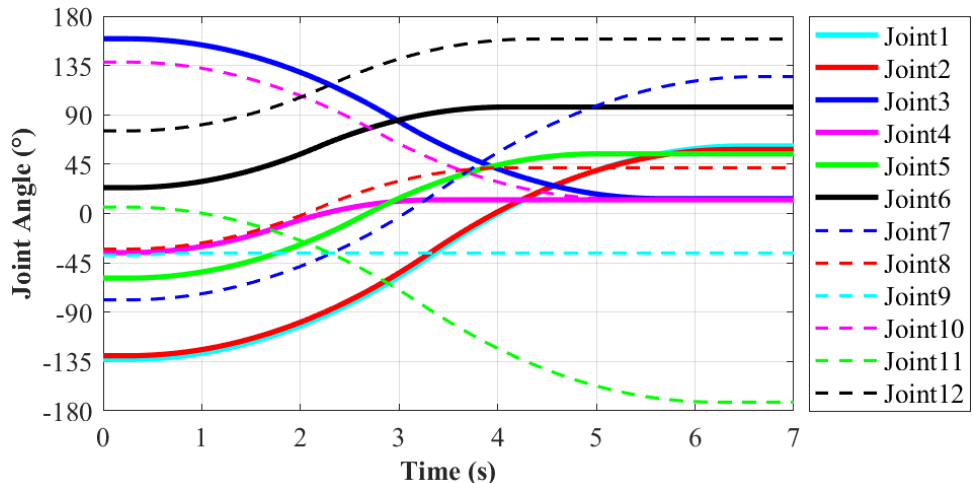
Figure 10. The angle variation of each joint. (Action 9 according to Table 1).